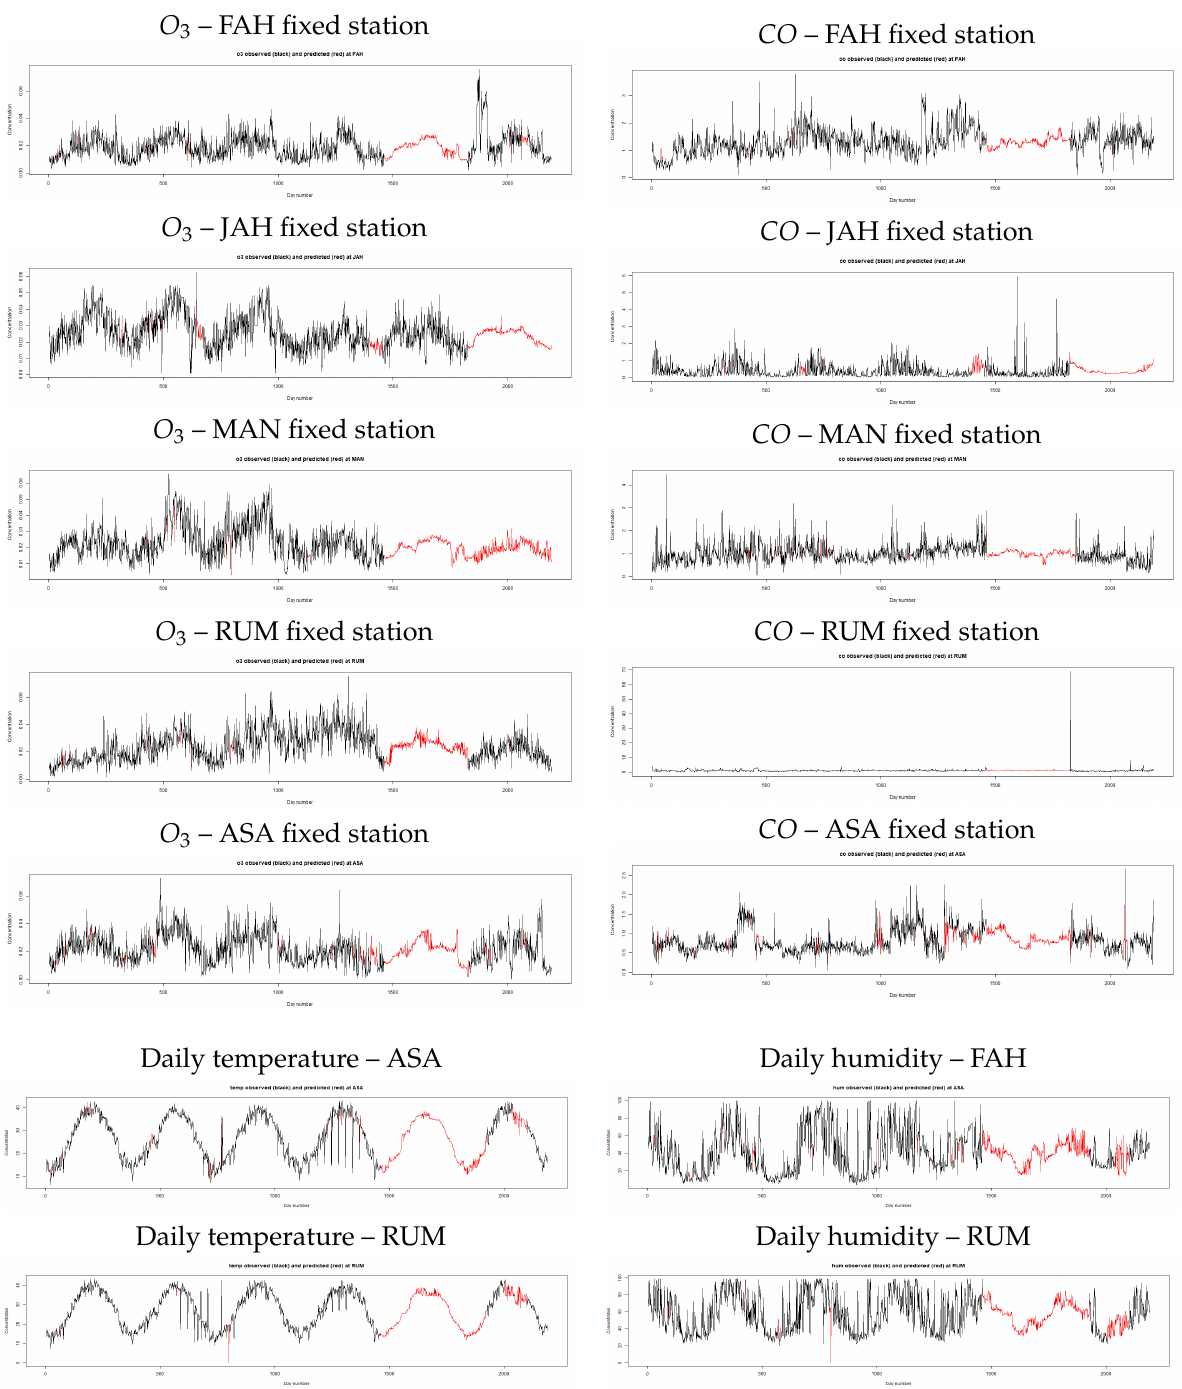
Figure 6. Daily concentrations of O 3 , CO , temperature, and relative humidity after estimating missing values using the missForest approach (from 2012–2017).